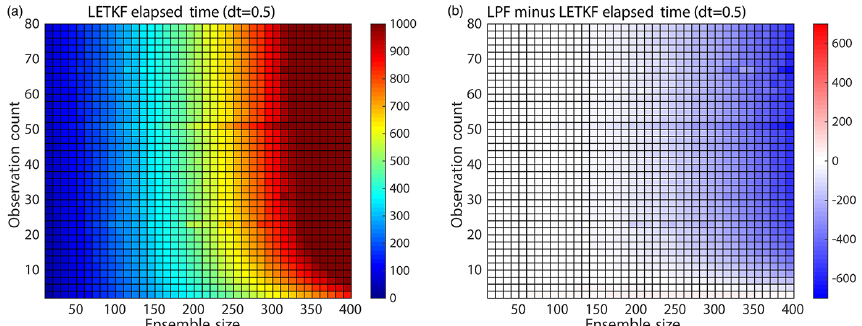
Figure 6. Elapsed time in seconds for (a) LETKF and (b) LPF minus